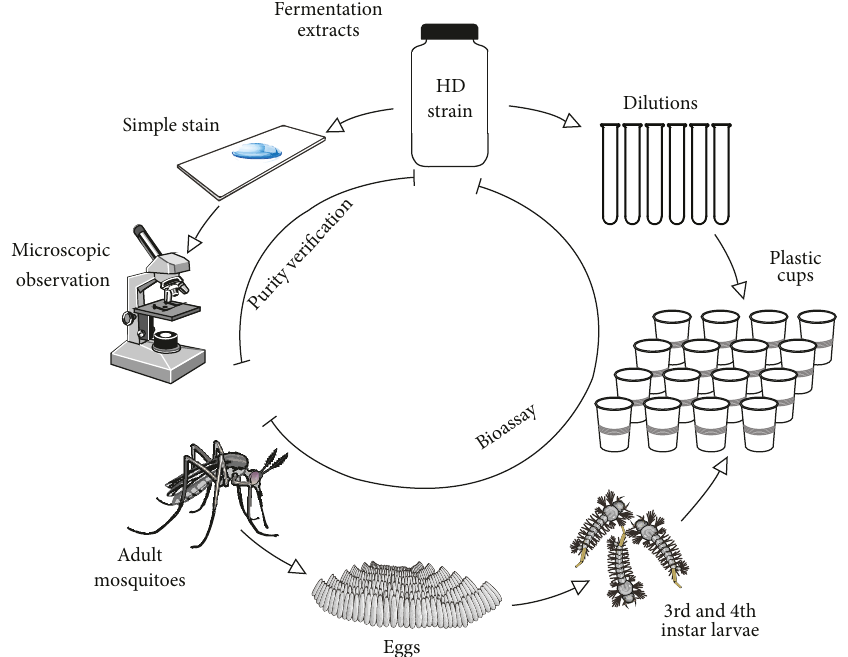
Figure 1: Diagram of experimental